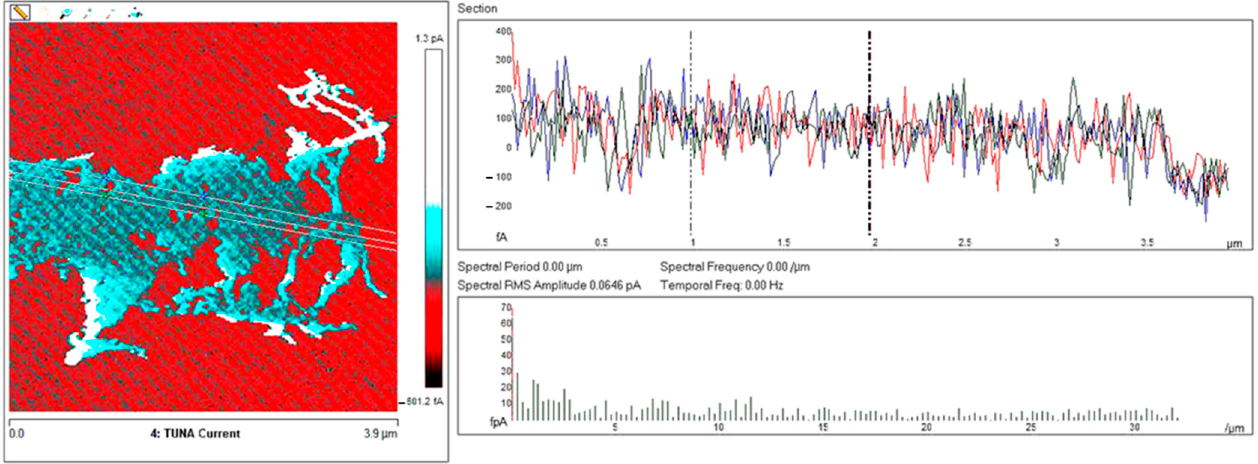
Figure 10. From left to right, TUNA Current picture and current variation profile of the sample TCTBD+2%MWCNT–t.